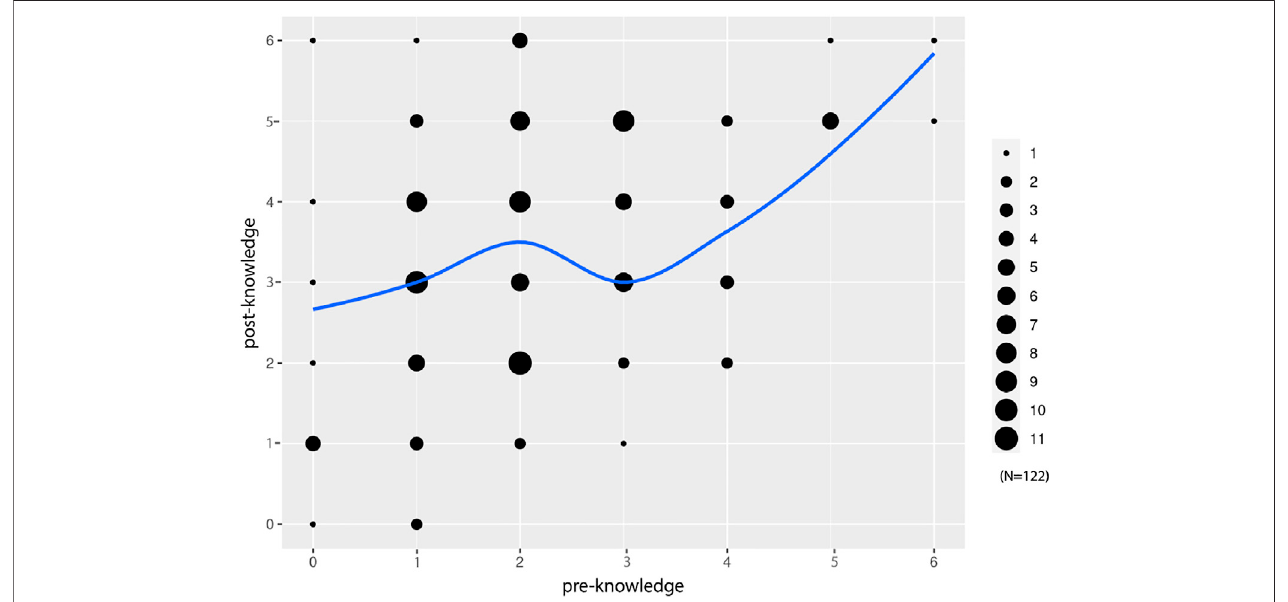
FIGURE 2 | Pre- and post-knowledge relation. The bigger the bullet in the graph, the more participants it covers. The blue line shows the trajectory of the correlation.